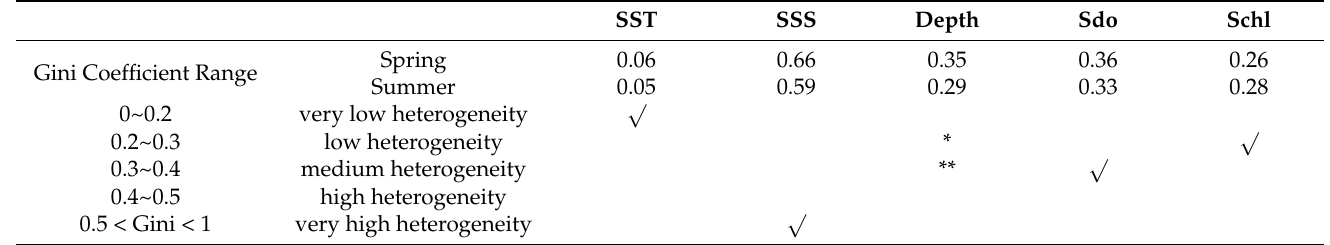
Figure 3. Lorenz curves of environmental factors in the Yangtze Estuary (2018–2020; the black dashed line represents the line of equality; the colorful lines are the Lorentz curves, the greater the curvature of the curve, the more heterogeneous the environmental factors are distributed spatially). Table 1. Spatial heterogeneity of environmental factors in the Yangtze Estuary in spring and summer